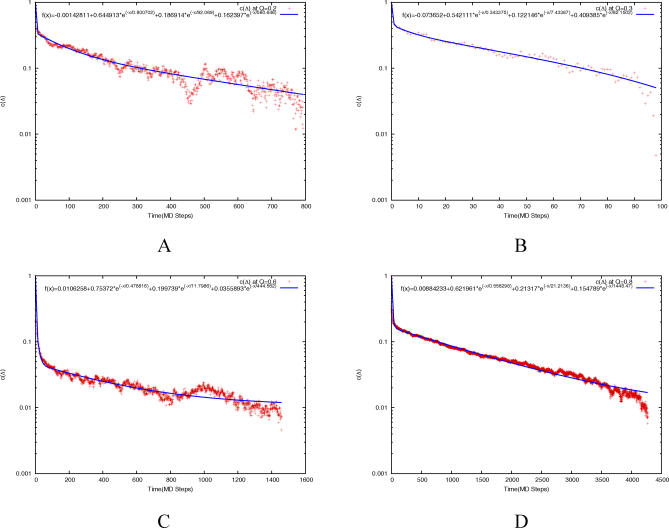
Auto-Correlations of Fraction of Interface Contacts c(Δ) at Different Positions of Qb and at T = Ts